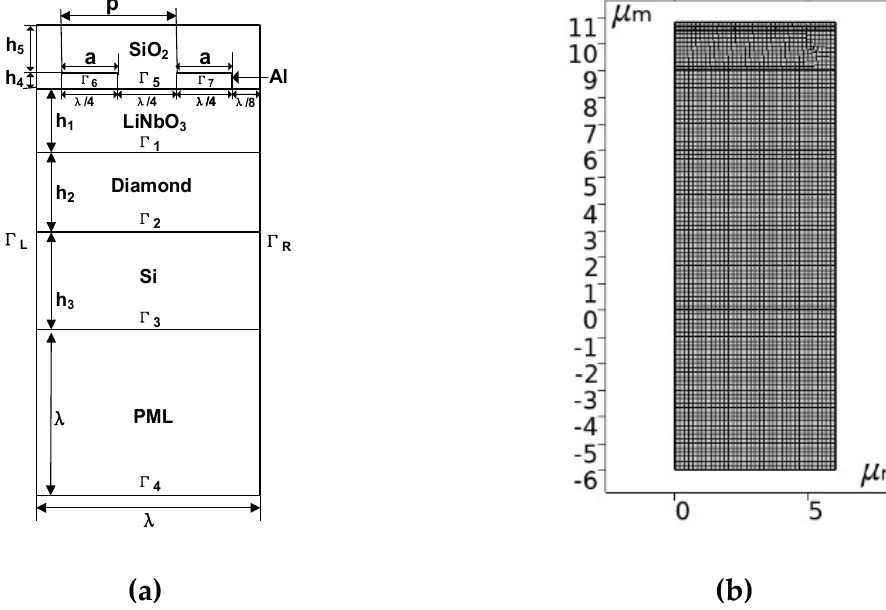
Figure 3. ( a ) Schematic representation of the studied structure in the model. ( b ) Single pair IDT model meshing, quadrilateral elements = 3675 Table 1. Geometric parameters for design.